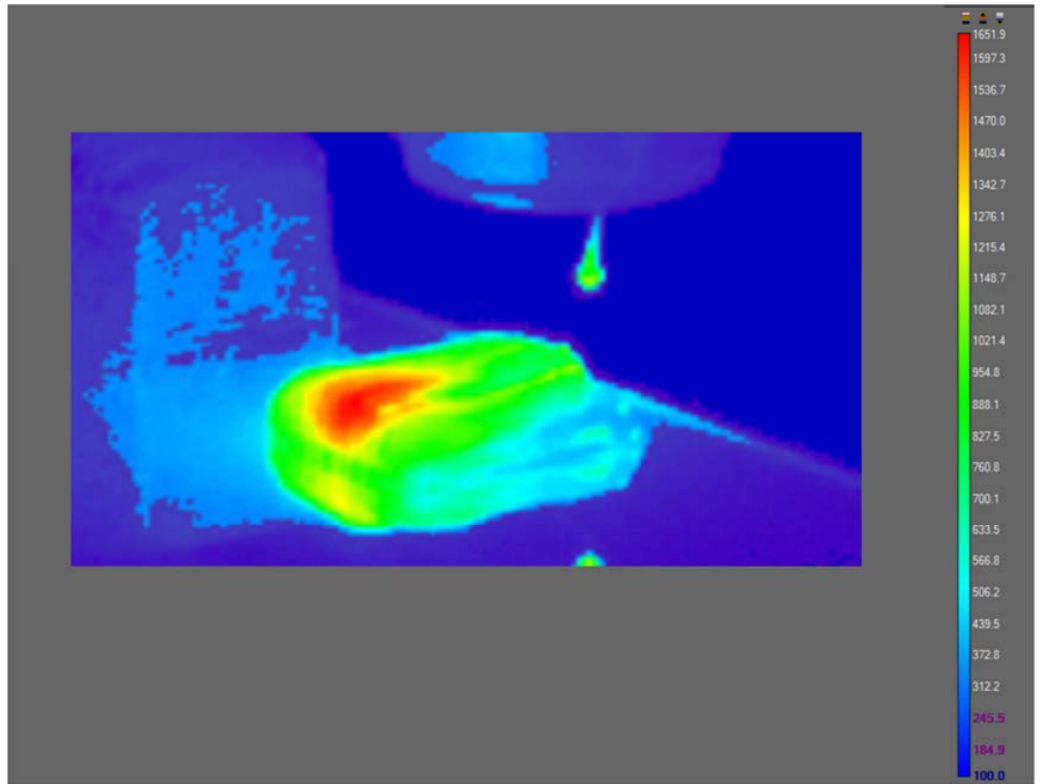
Figure 10. IR image taken at the end of the welding process.